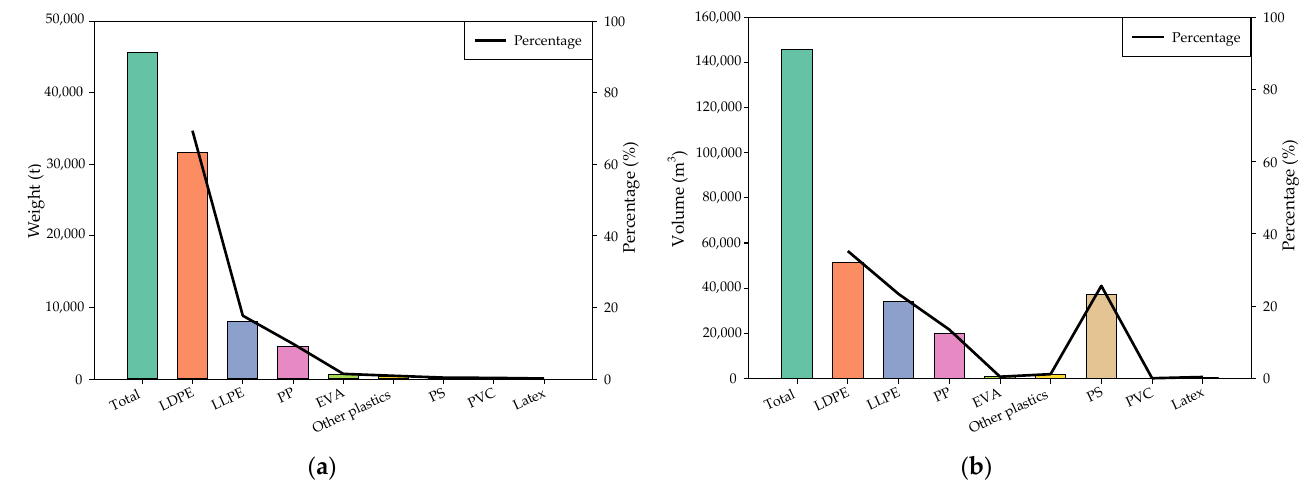
Figure 1. Generation of plastic waste/by-products in the Almeria model subdivided by type of polymer: ( a ) mass estimation; ( b ) volume estimation. LDPE: low density polyethylene; LLDPE: linear low density polyethylene; EVA: ethylene-vinyl acetate; PVC: polyvinyl chloride; HDPE: high density polyethylene; PP: polypropylene; PS: polystyrene. Source: own elaboration based on data provided by other authors [22].